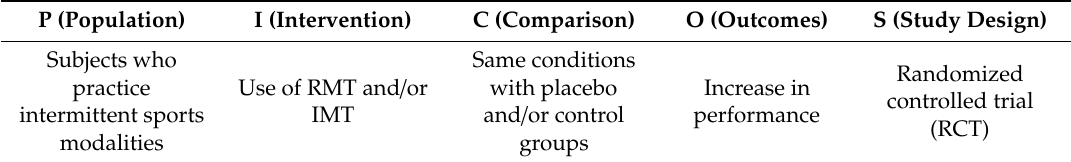
Table 1. PICOS question